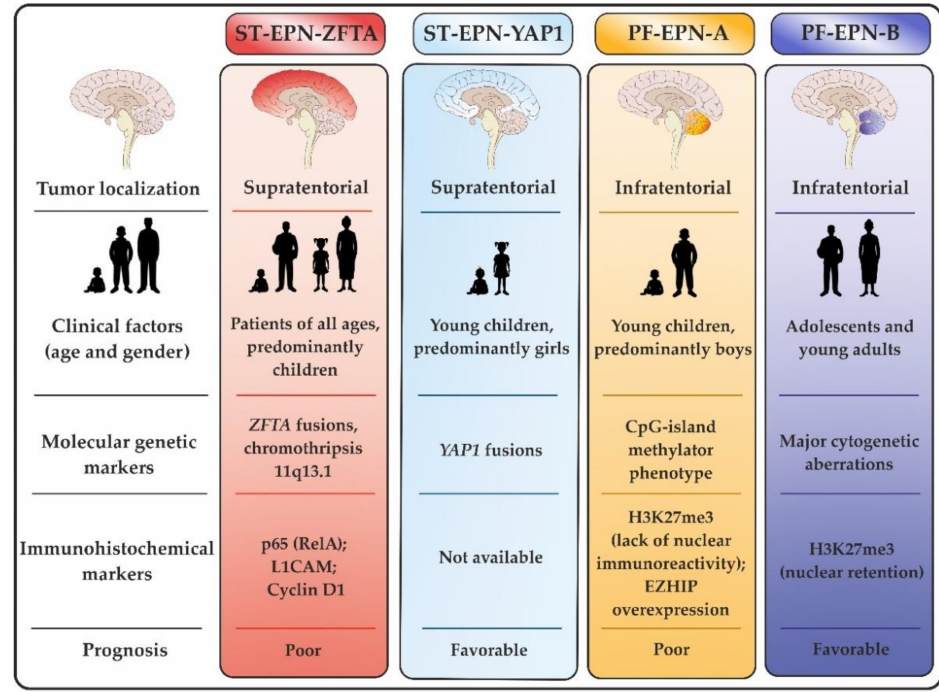
Figure 1. Basic classification of intracranial ependymal